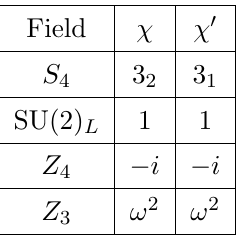
Table 2 . New (cid:13)avon (cid:12)elds with their respective transformations under the symmetry group of the